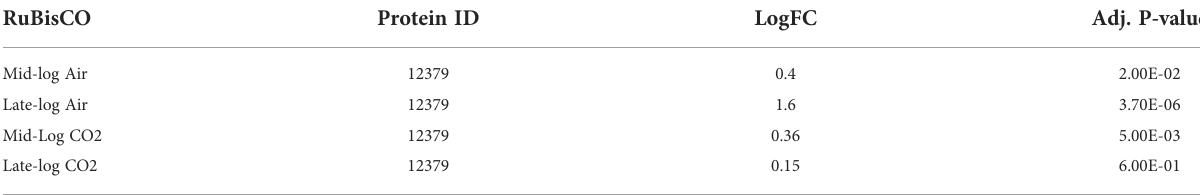
TABLE 2 Log fold changes and adjusted p-values of transcripts encoding ribulose bisphosphate carboxylase oxygenase (RuBisCO) of S. obliquus grown in the presence of switchgrass in ambient and 1% CO 2 during mid- and late-log phase growth.